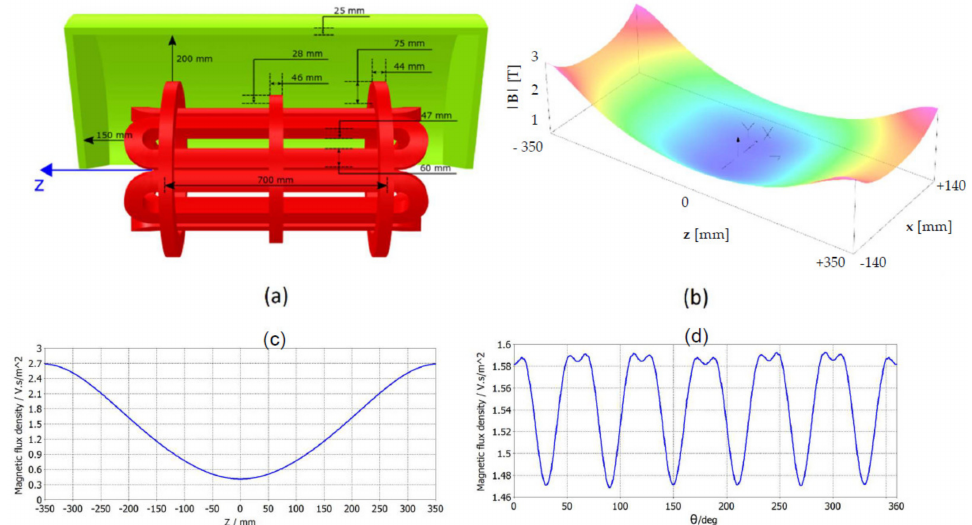
Figure 3. ( a ) Side view of the PANDORA magnetic system, together with the simulated coil dimen- sions. Superconducting coils will be contained in a single cryostat surrounded by an iron yoke shown in green. ( b ) Plot of |B| inside the plasma chamber over the Y = 0 plane. ( c ) Magnetic field module, |B|, along the plasma chamber Z axis. ( d ) Radial field component module, |B hex |, of the hexapolar stand-alone structure at R CH_IN = 140 mm and z = 0 mm, along the azimuthal angle θ